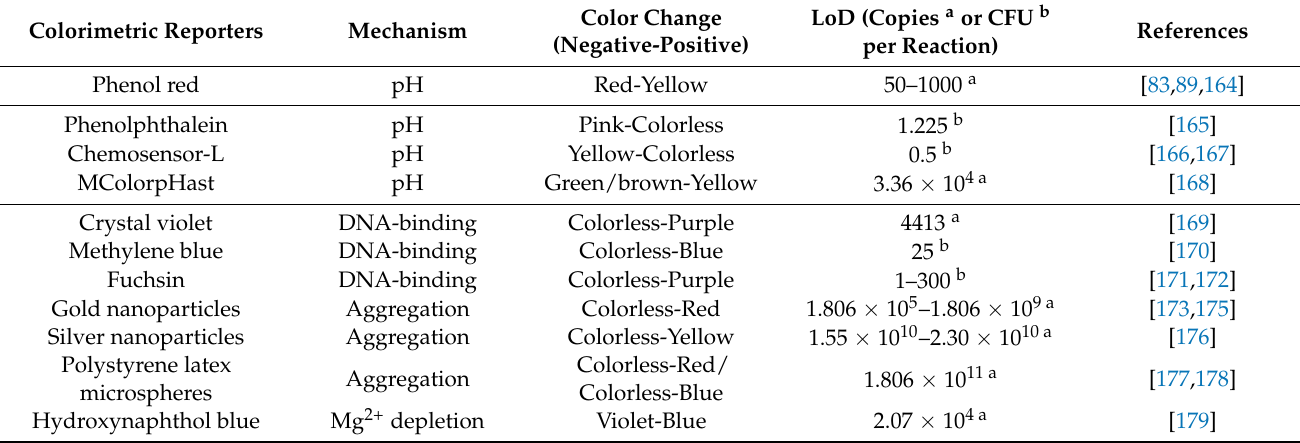
Table 2. Summary of colorimetric reporters and their